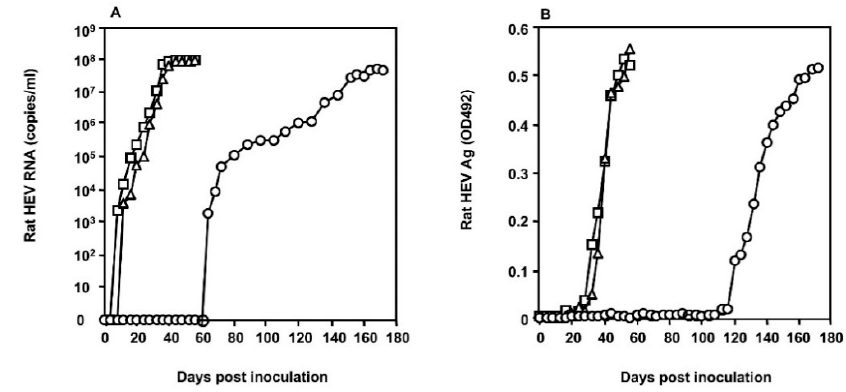
Figure 2. Replication of S1129 in the human hepatocarcinoma cell line PLC/PRF/5. Two mL of 10% fecal suspension was inoculated onto PLC/PRF/5 cells. The culture supernatants were collected every 4 days and used for the detection of rat HEV RNA by RT-qPCR ( A ) and for the capsid antigen detected by rat HEV-specific antigen enzyme-linked immunosorbent assay (ELISA) ( B ). The first (S1129c1) ( ○ ), second (S1129c2) ( ∆ ), and third (S1129c3) ( □ ) passages in the PLC/PRF/5 cells are